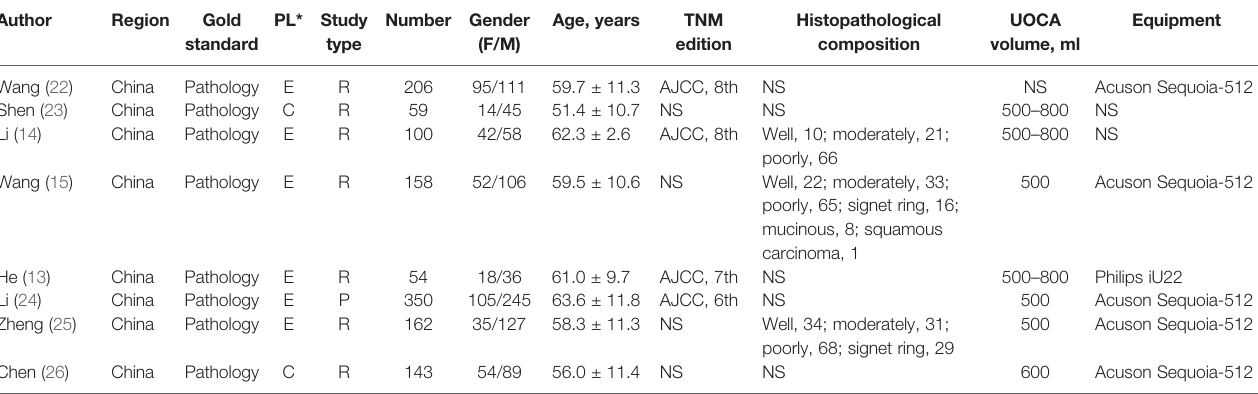
TABLE 1 | Characteristics of the studies